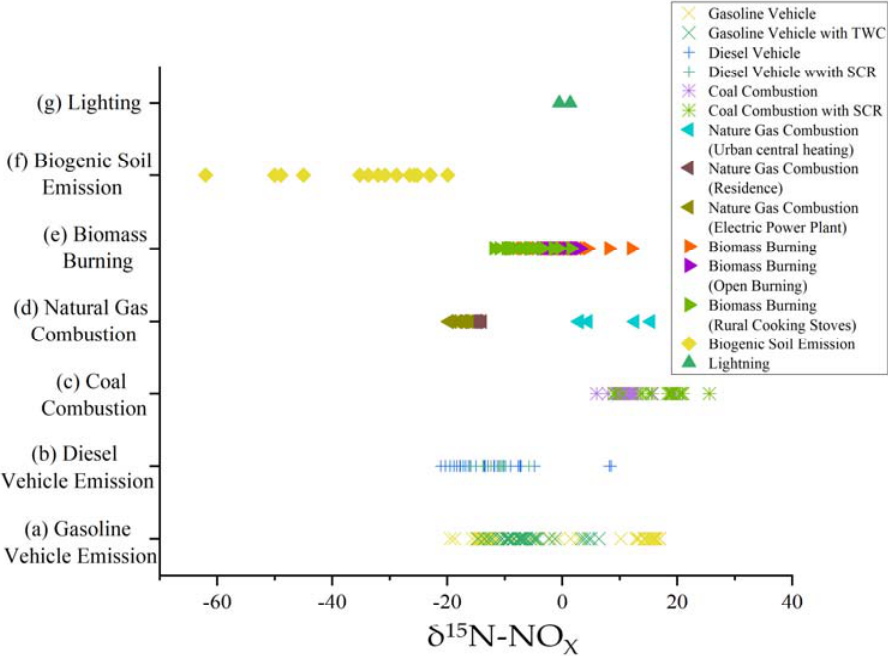
Figure 4. δ 15 N values for NO X emissions from different sources. The Y-axis indicates different sources of NO X emissions and the X-axis indicates the δ 15 N-NO X value, with one point representing a measured value; different colors indicate different NO X generation processes for this